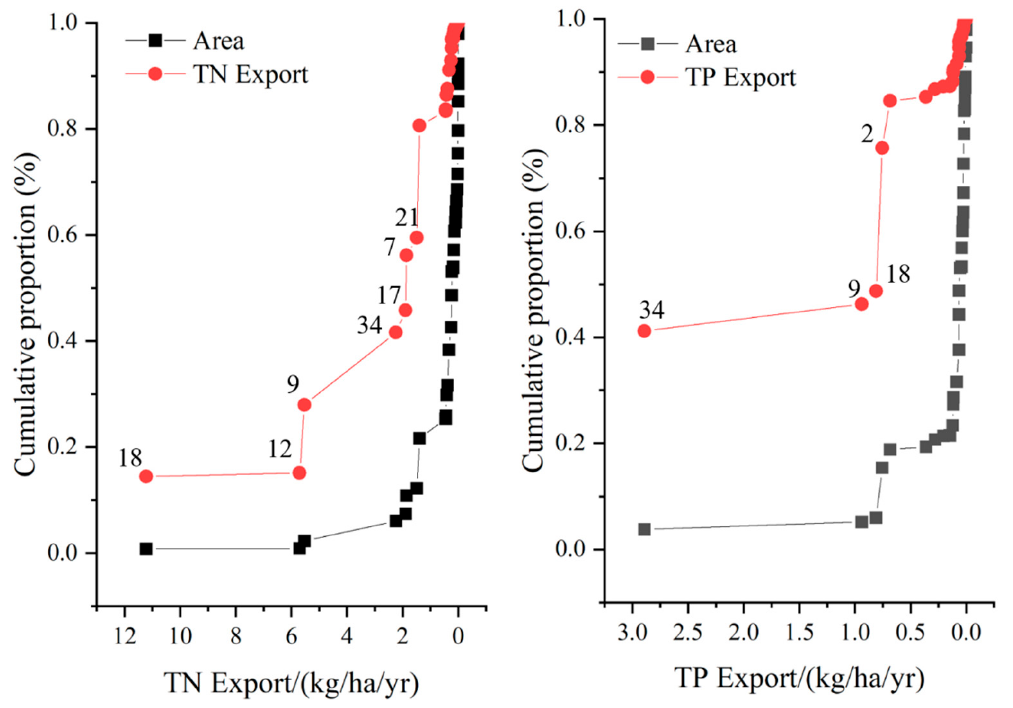
Figure 8. Contribution of individual sub-basins to the N and P export at the NELB outlet.